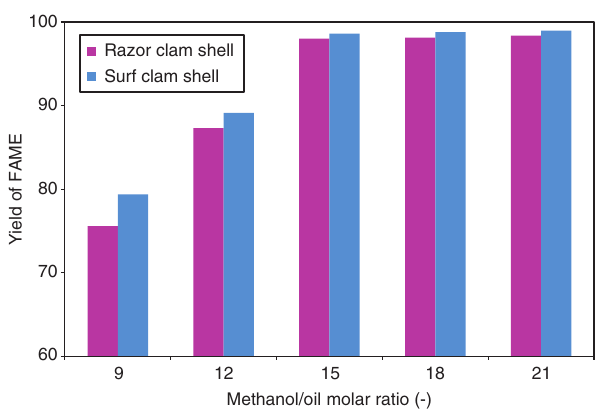
Figure 10: Effect of repeated operation of packed bed reactor (PBR) on % yield of fatty acid methyl ester (FAME) (catalyst bed length 250 mm, cycle time 1.5 h, reaction temperature 60 ° C, and methanol/oil molar ratio